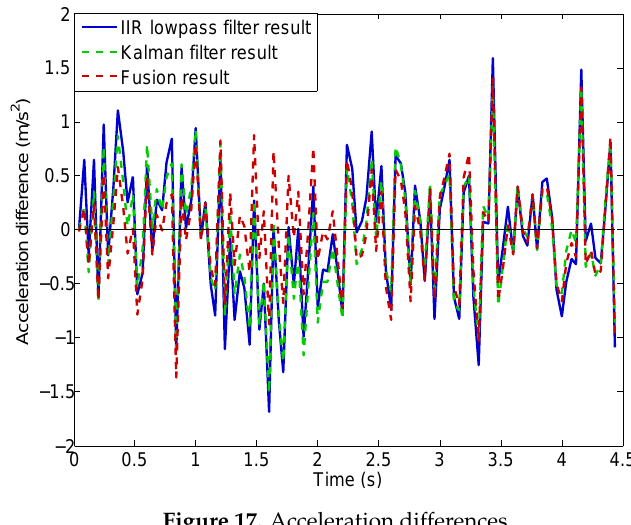
Figure 17. Acceleration differences.